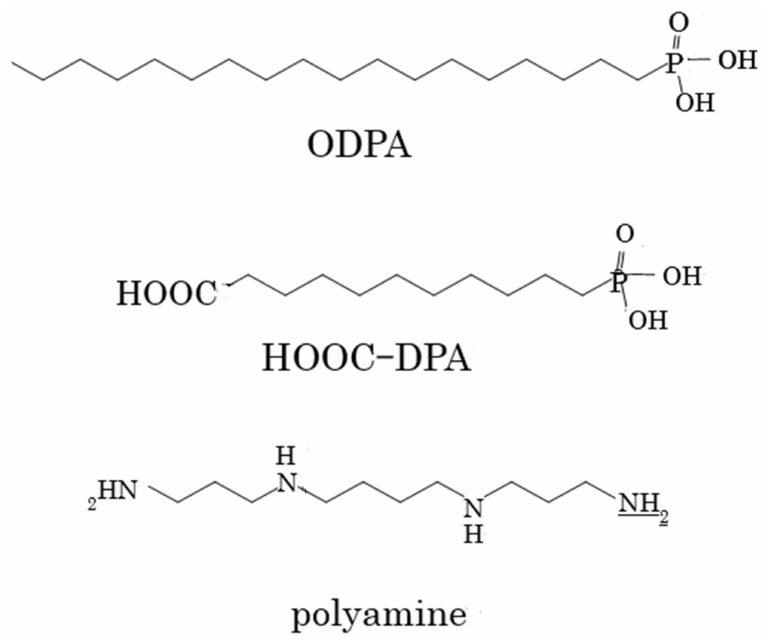
Scheme 1. Chemical structures of alkyl phosphates and the